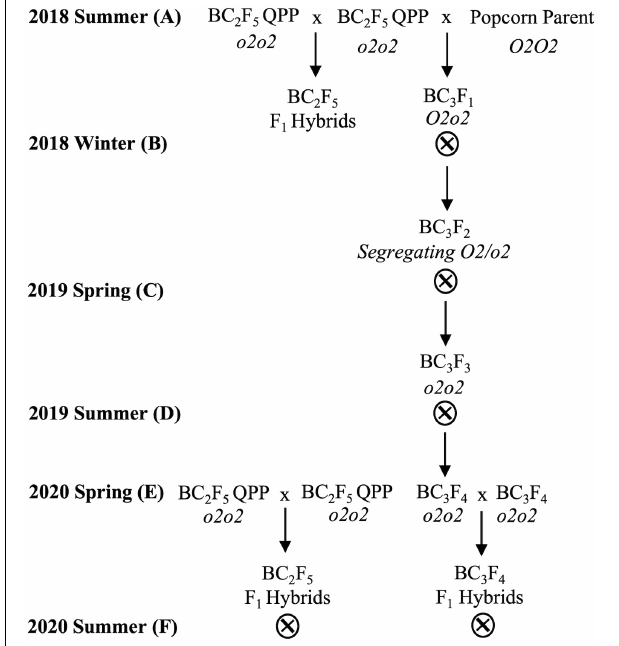
Figure 1 ). Equation 3 estimates from test weight and